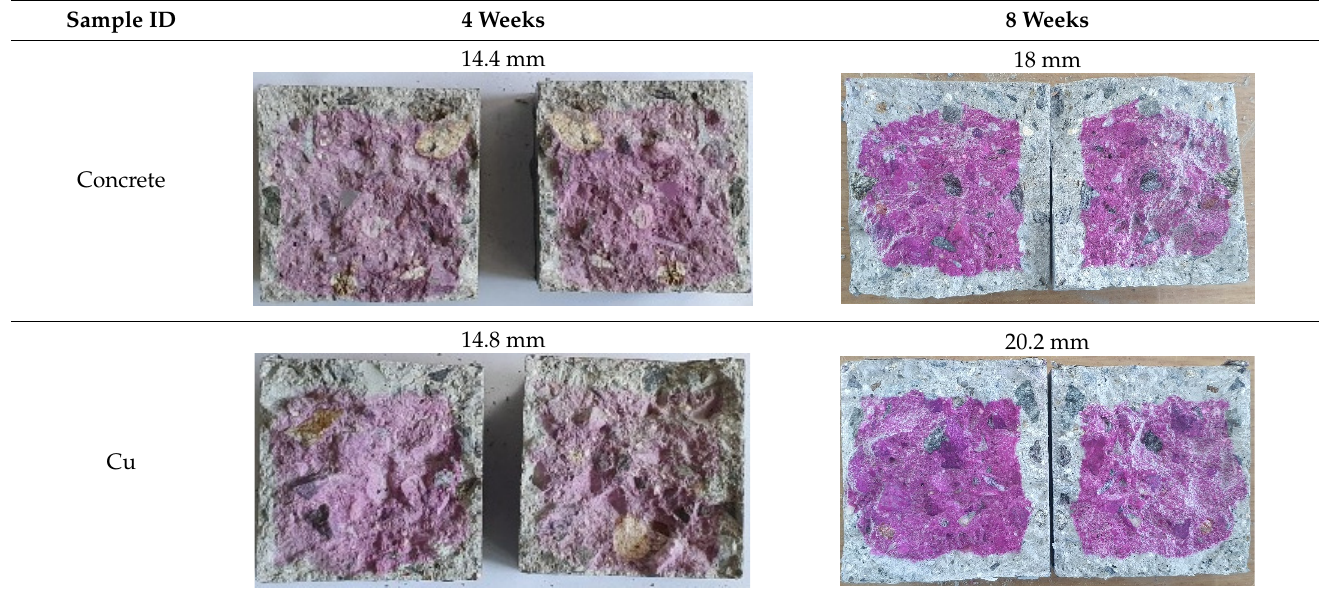
Table 3. CO 2 penetration depth and resistance measurement.